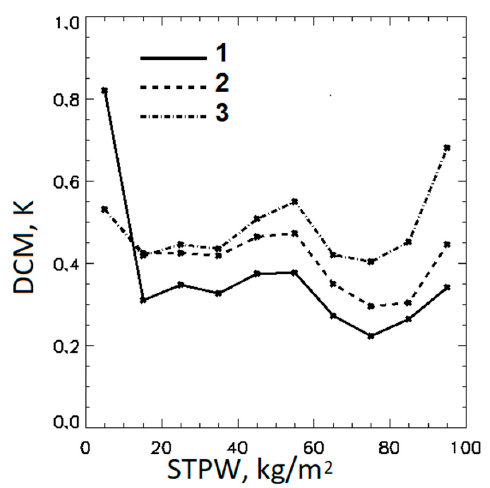
Figure 9. Mean DCMs for (1) GR-IS SST, (2) GR-L4 SST, and (4) PWR-L4 SST, averaged from 1 to 31 March 2018, as functions of STPW.